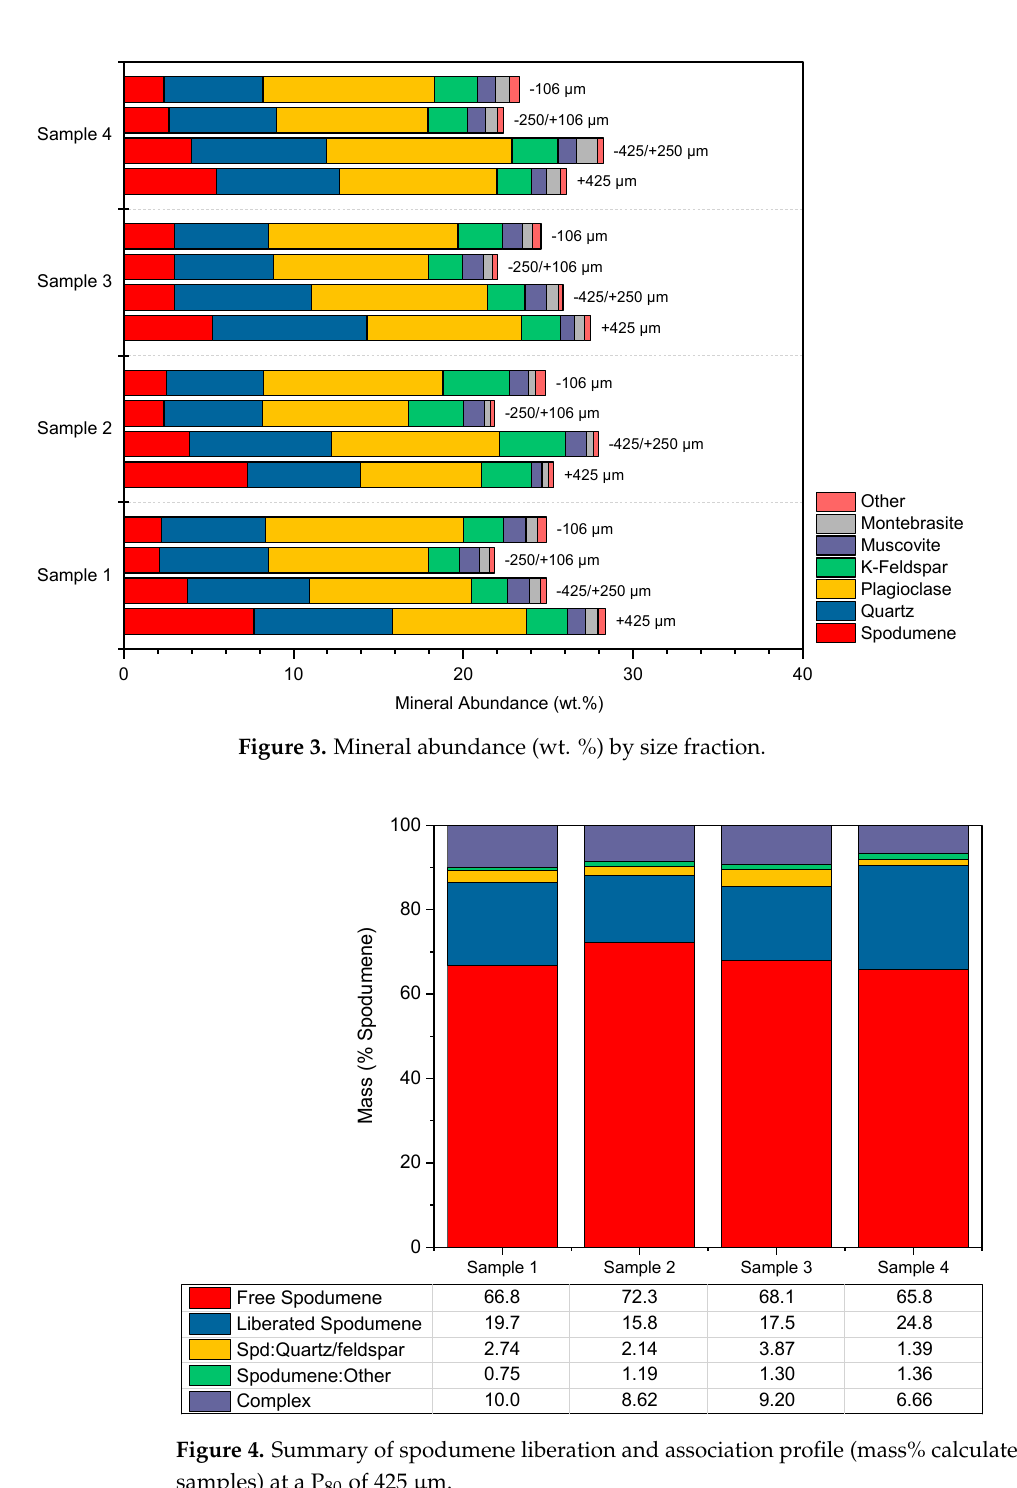
Figure 4. Summary of spodumene liberation and association profile (mass% calculated for the head samples) at a P 80 of 425 µm.